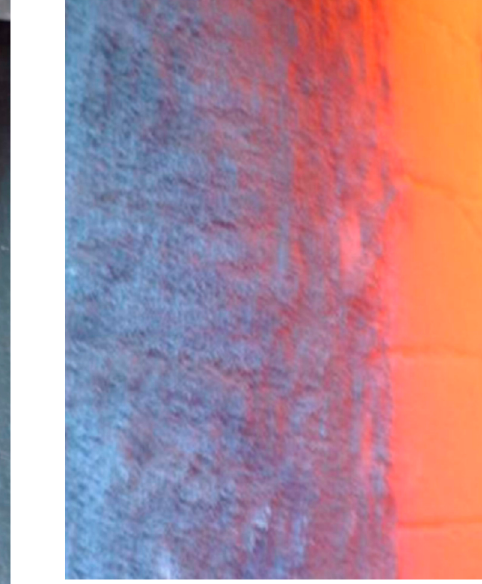
Table 1. Characteristics of silica refractories.